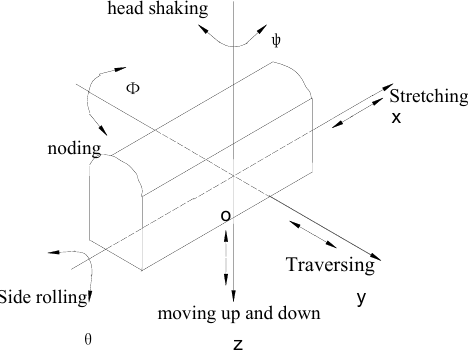
Figure 2. Spatial degrees of freedom of vehicle body.